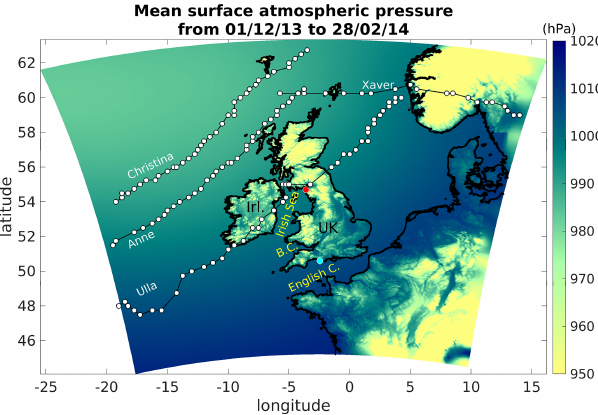
Figure 1. The UKC4 model domain with shading giving the UKC4 simulated mean surface atmospheric pressure during the 3 months of winter 2013/4. The figure also shows the estimated track of four storms during winter 2013 (storms Xaver 5 December 2013, Anne 3 January 2014, Christina 7 January 2014, and Ulla 14 Febru- ary 2014). Tracks are obtained from the mean sea level pressure (MSLP) of hourly ERA5 reanalysis data. The white markers show the location of hourly minimum MSLP during the storm period. The red and blue dots show the locations of Solway Firth and Weymouth respectively, which are mentioned in the